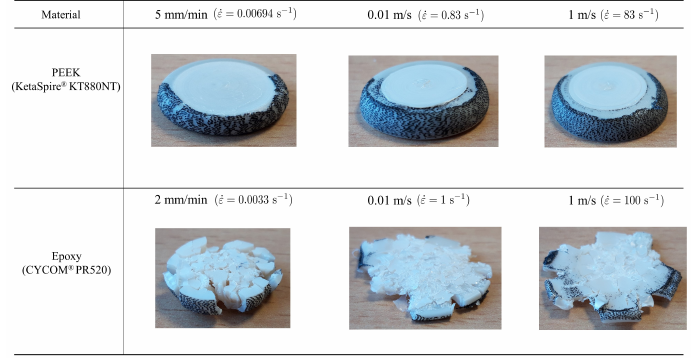
Figure 6. Morphology of samples at different strain rates at the end of the tests: PEEK KT880 − NT and PR520.